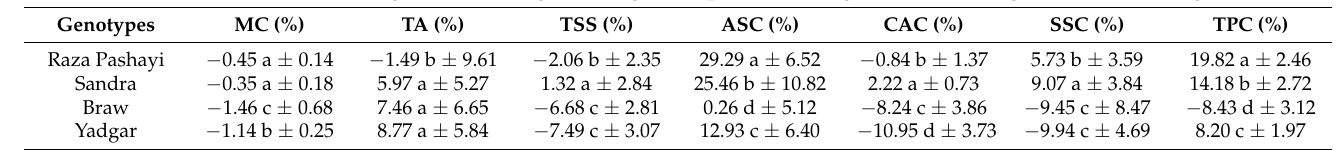
Table 4. Effect of tomato genotypes treated at various stress stages with oak leaf powder, oak leaf extract, and biofertilizer on the fruit physicochemical traits. Increasing and decreasing percentages are indicated by positive and negative values,